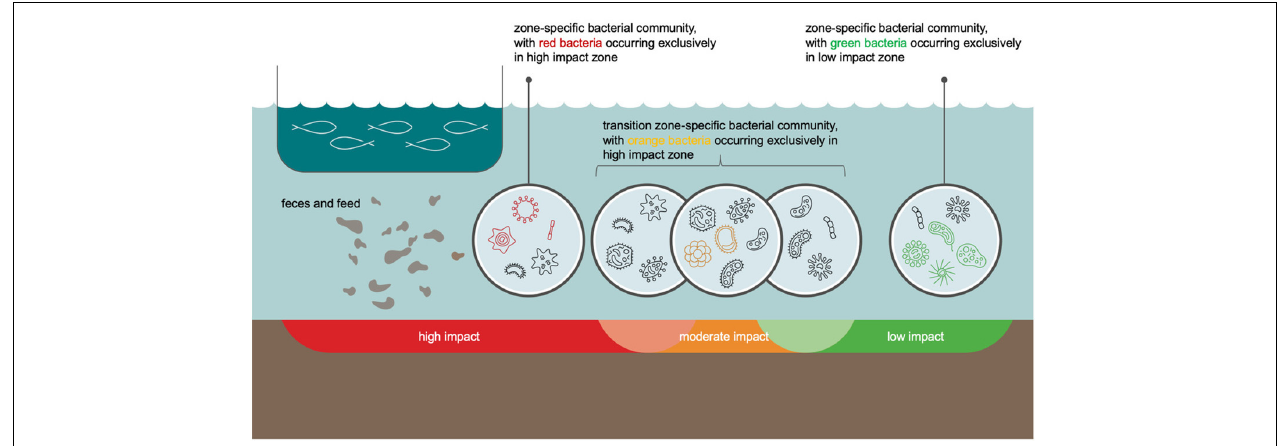
FIGURE 5 | Conceptual graphic of changes in bacterial community composition along an aquaculture-related impact gradient (the “benthic cage aquaculture footprint”). The graphic represents especially the difficulties in identification of bacterial taxon groups that are typical of moderate impact conditions (orange benthic zone). This zone is a transition from high (in red) to low (in green) benthic impact and, thus, a melting pot that includes bacteria from all impact categories. Only few bacteria (marked in orange) have such a narrow ecological niche that they do not extend out of the transition zone into regions with high or low impact. On the other hand, some bacteria that are more typical of low or high impact conditions have an ecological tolerance to environmental conditions, which allows them to extend from regions of low or high impact, respectively, to regions of moderate impact. In environmental monitoring, relative abundance distributions of all bacterial taxon groups at each sampling site are considered, which, in concert, help to identify moderate impact conditions. Bacteria that are exclusive for high, moderate, and low impact conditions are visualized by their color code for each of these impact categories (red, orange, and green, respectively). Bacteria marked in black are bacteria that occur across two impact categories in the transition